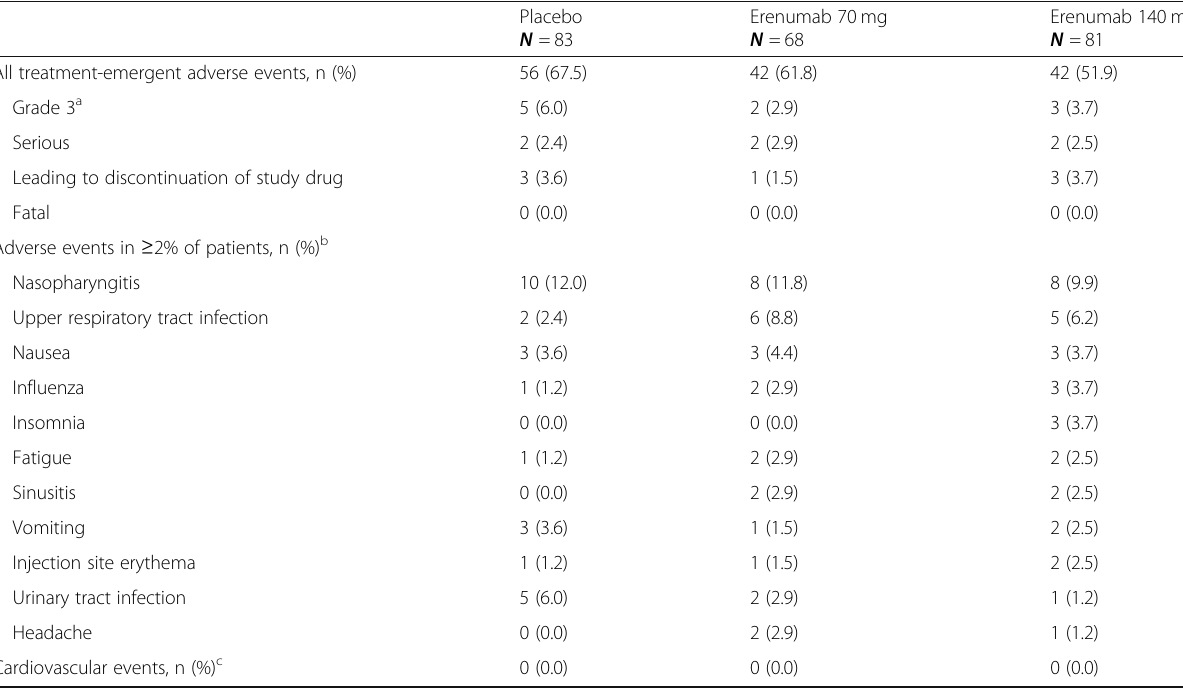
Cardiovascular events, n (%) c 0 (0.0) 0 (0.0) 0